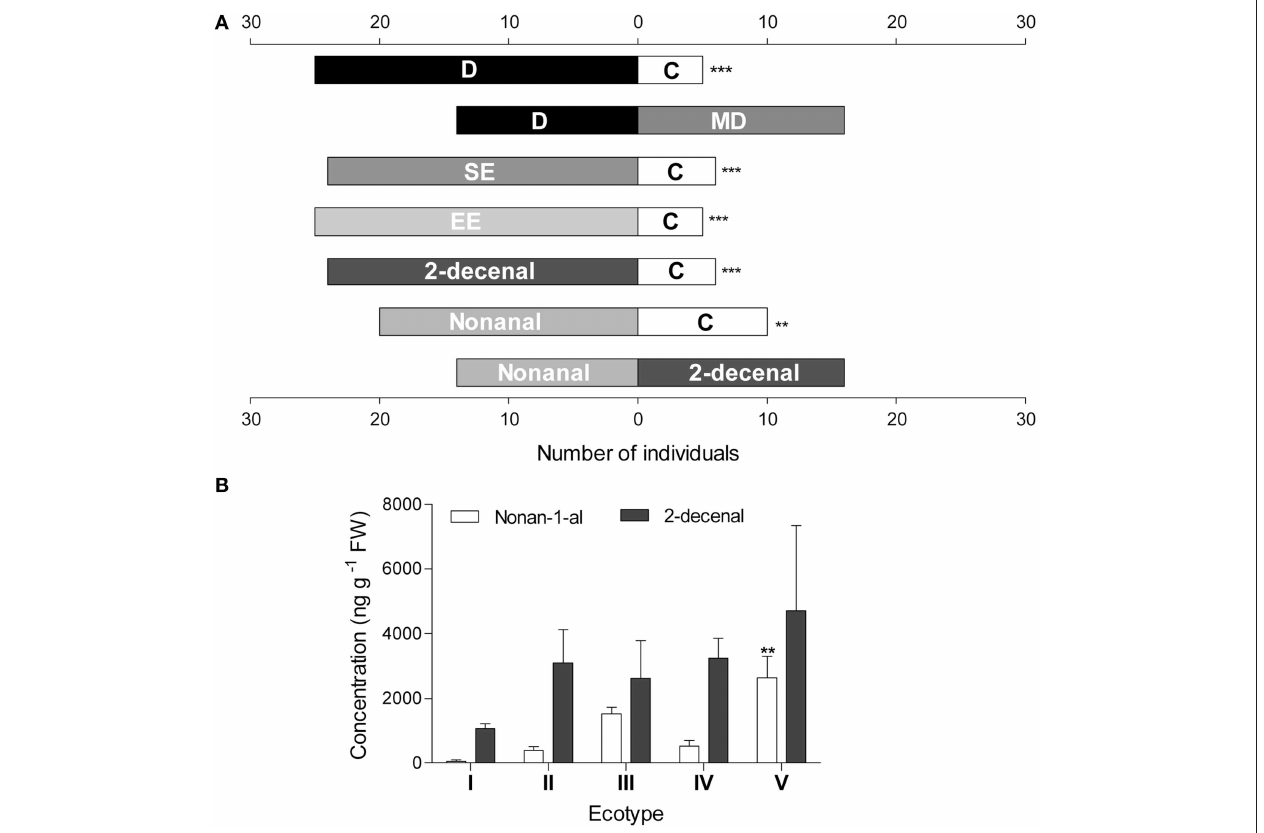
FIGURE 3 | (A) Y-tube olfactometry assay. Results are presented as binary choices between treatments. Asterisk indicates significant difference between treatments using two-sided binomial test ( p ≤ 0.001, n = 30) (D, Diaspores; MD, manually detached seeds; SE, seed extract; EE, elaiosome extract; C, control). (B) Composition of dichloromethane extracts of R. communis elaiosomes. Data represent mean ± SE of the concentration (mg g − 1 FW) measured using GCMS analysis. Asterisk indicates significant differences in individual volatile concentrations between varieties, tested using Bonferroni’s post-hoc test after one-way ANOVA ( p ≤ 0.01, n =